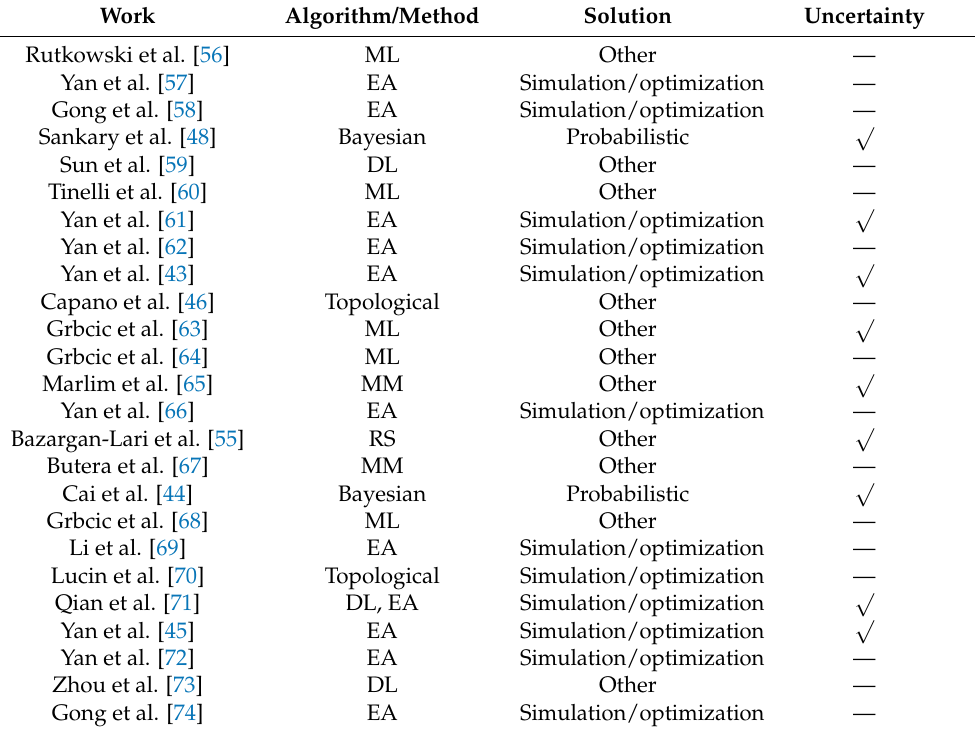
Table 3. Literature review of CSI